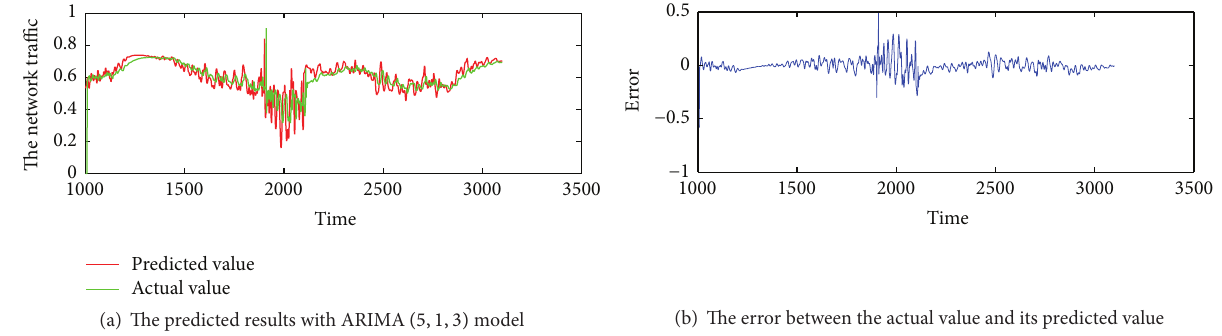
Figure 10: Prediction results with ARIMA method.